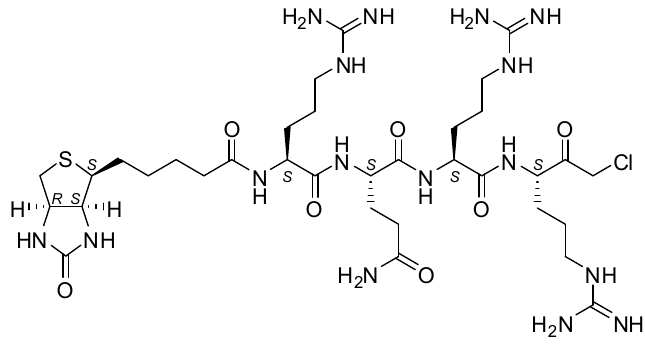
Figure 1. Structure of biotin-RQRR-CMK.